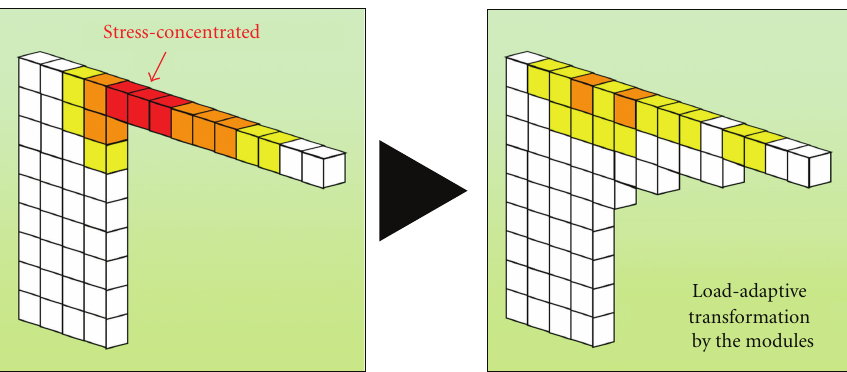
Figure 2: Objective structural transformation (modules construct a cantilever structure with reinforcing the overstressed parts).